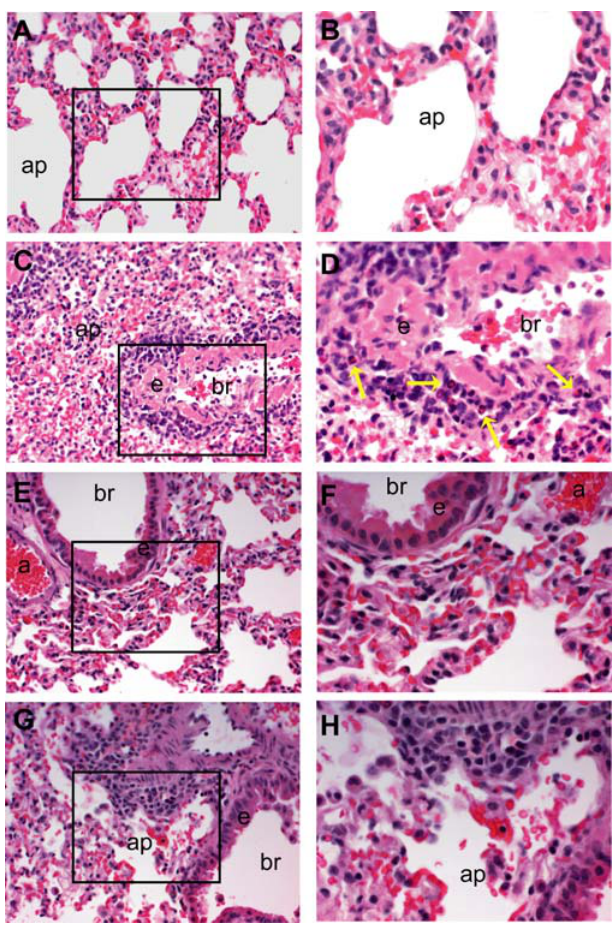
Figure 8. Pathogenic Findings Following Heterologous Challenge Light photomicrographs of representative histologic lung sections (Table 1, experiment 4) taken from a mock PBS–vaccinated mouse (A) and (B), a VRP-N–vaccinated mouse (C) and (D), a VRP-S–vaccinated mouse (E) and (F), or a VRP-S þ N–vaccinated mouse (G) and (H). The boxes in (A), (C), (E), and (G) (200 3 magnification) denote the site of the light photomicro- graph that was taken at a higher magnification (400 3 ) to better illustrate the lymphoplasmacytic inflammatory cell infiltrates including eosinophils (yellow arrows). All tissues were stained with hematoxylin and